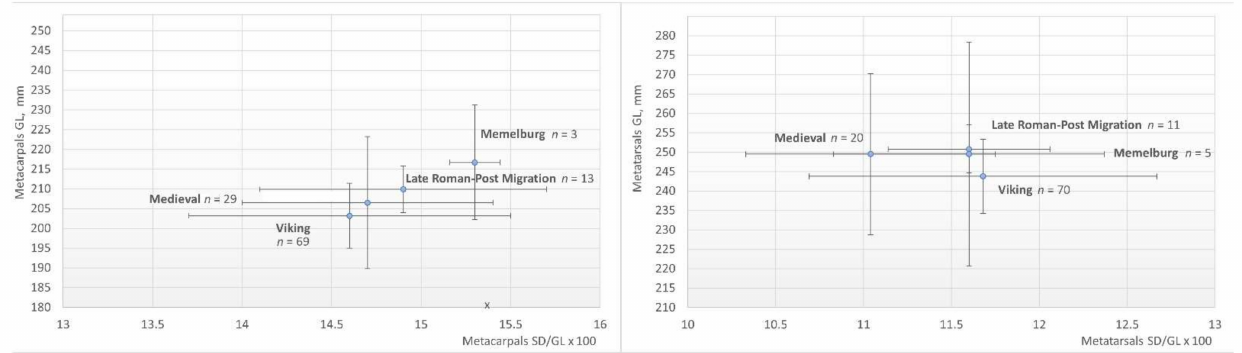
Figure 8. Scatter plot of mean ratios of measurements SD/GL × 100 of metacarpal bones (bars are mean ±